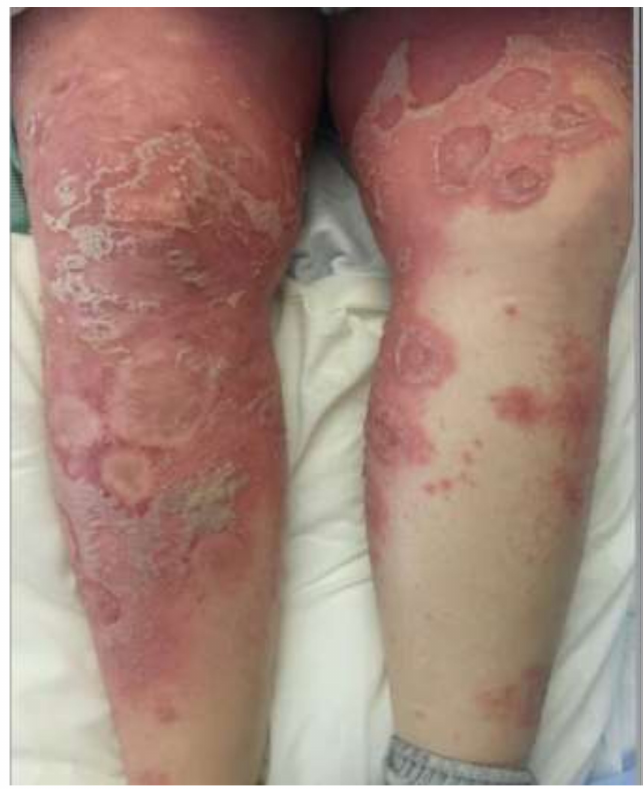
Figure 1. Generalized pustular psoriasis. Erythematous plaques covered by pustules, which demon- strate